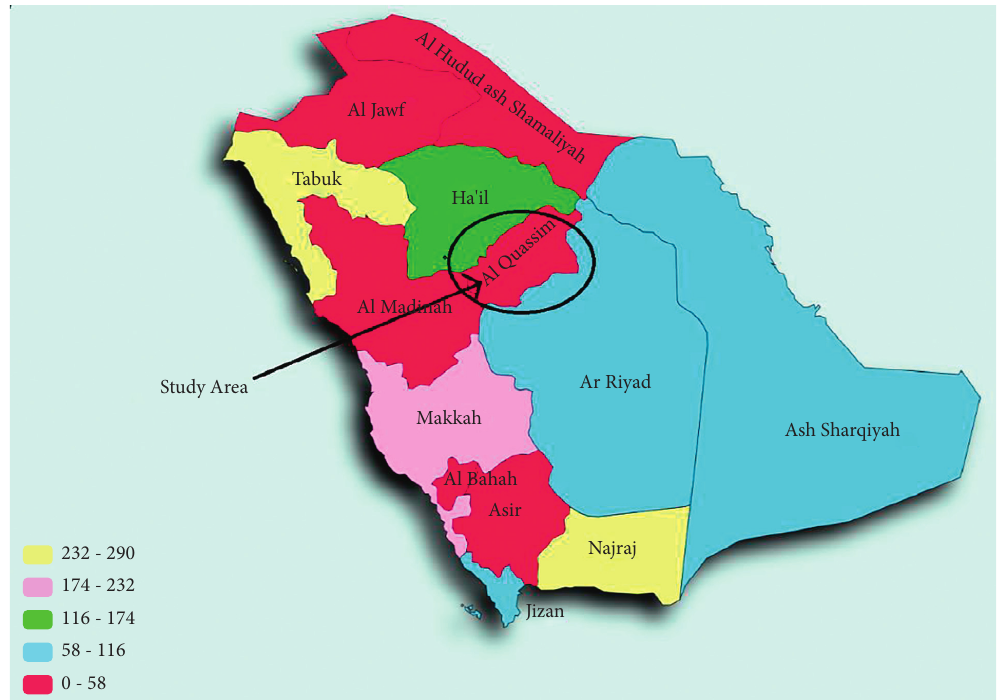
Figure 1: (Color) Experiential area location of Al-Qassim Region, Saudi Arabia [13]. Table 1: The date of low temperature � T ° C); high temperature Tmax ( ° C); humidity (%); wind speed (km/day); sunshine (hour); min ( radiation (MJ/m 2 /day) and reference evapotranspiration � ETo (mm/day); and rainfall (mm) and effective rainfall � P Statistical Yearbook, Ministry of Planning,